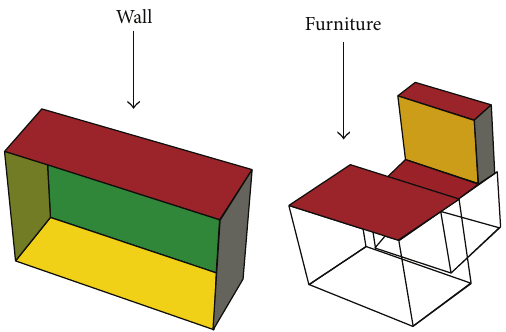
Figure 2: Object modeling of the simulation